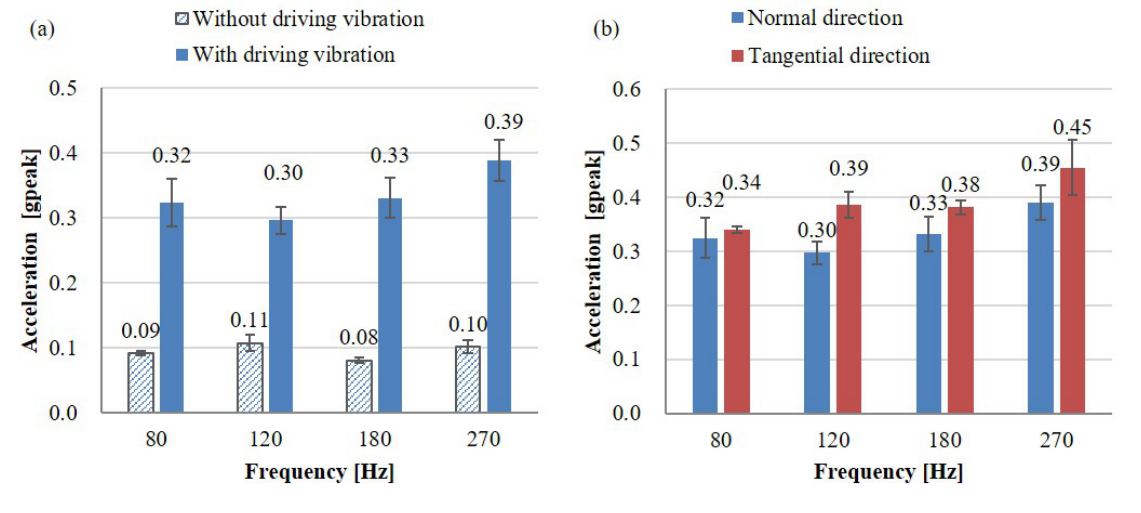
Figure 7. Comparison of the detection thresholds expressed as acceleration. ( a ) Comparison of detection thresholds of haptic stimulation in the normal direction between with and without driving vibration. ( b ) Comparison of detection thresholds of haptic stimulation with driving vibration between the normal and tangential